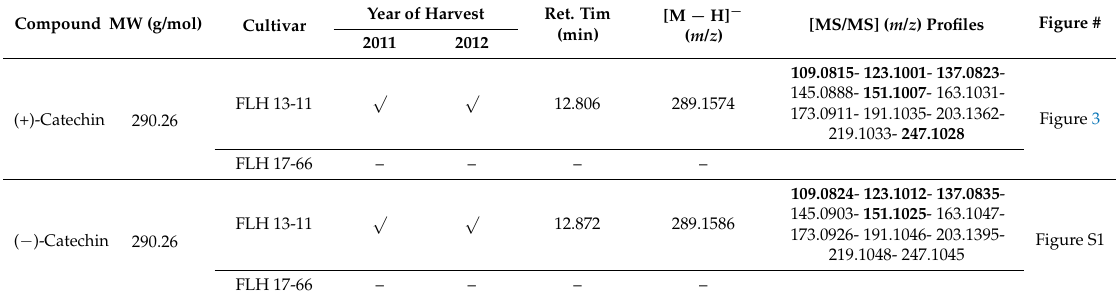
Table 2. Flavan-3-ol aglycones detected in berries of two interspecific hybrid cultivars FLH 13-11 and FLH 17-66. (Note: “–” means undetected, “